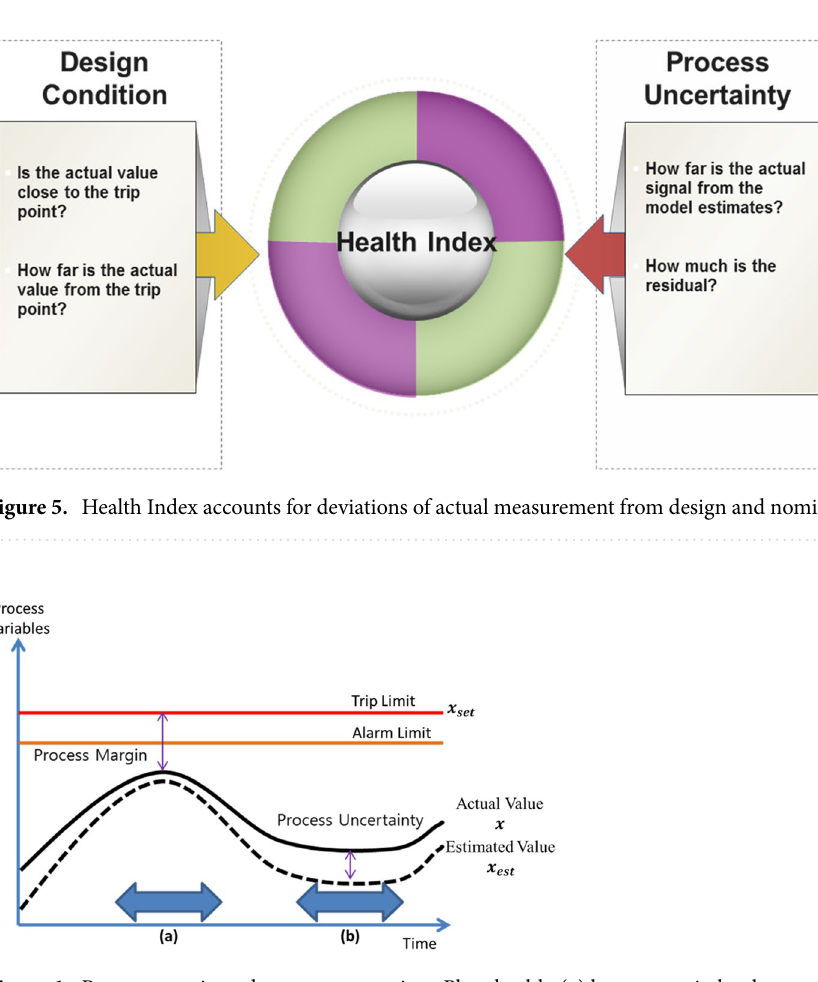
Figure 6. Process margin and process uncertainty. Plant health: ( a ) less uncertain but less margin, and ( b ) more margin but more uncertain.